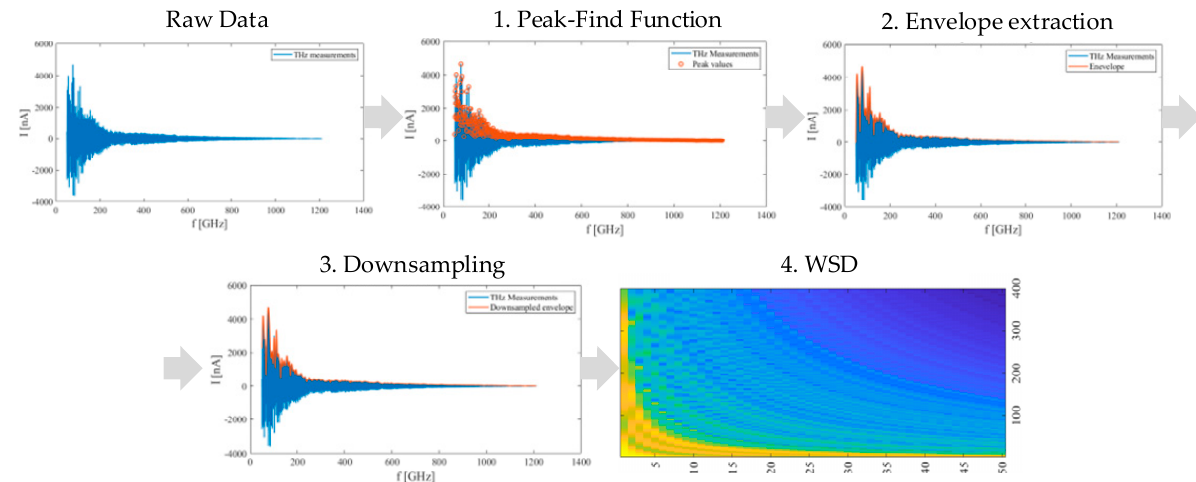
Figure 9. Preprocessing sequences; peak-find function, envelope extraction, downsampling, and WSD algorithm.